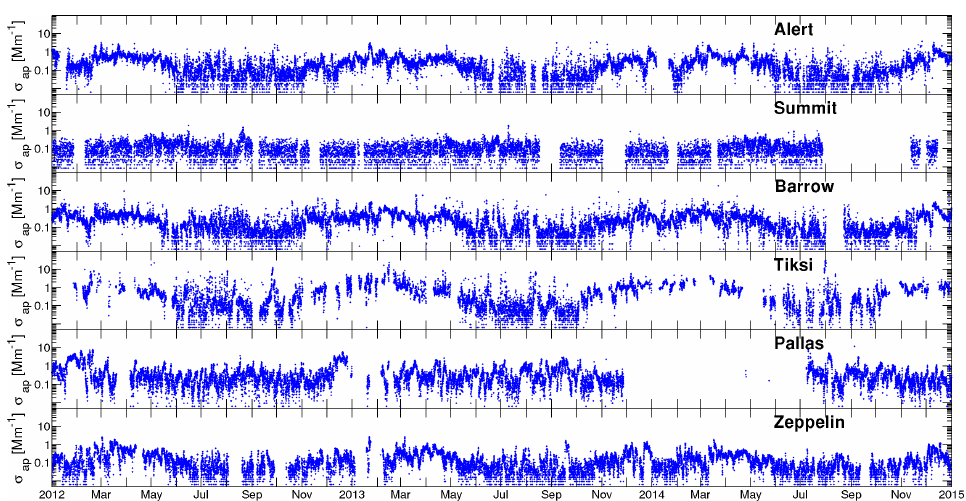
Figure 5. Time series of 1h averaged absorption data for λ = 520nm. In the figure, the attenuation coefficients have been corrected using the Arctic correction factor C f of 3.45.